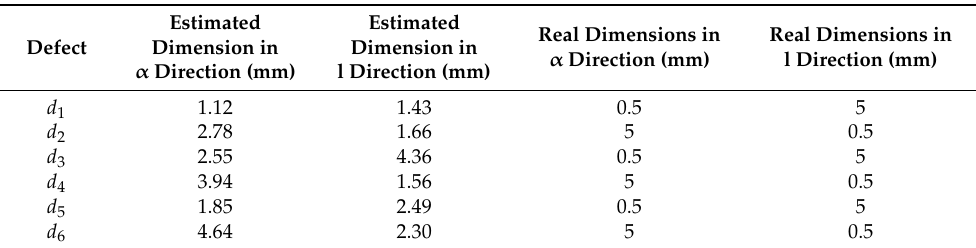
Table 3. Evaluation of inspected defect orientation.